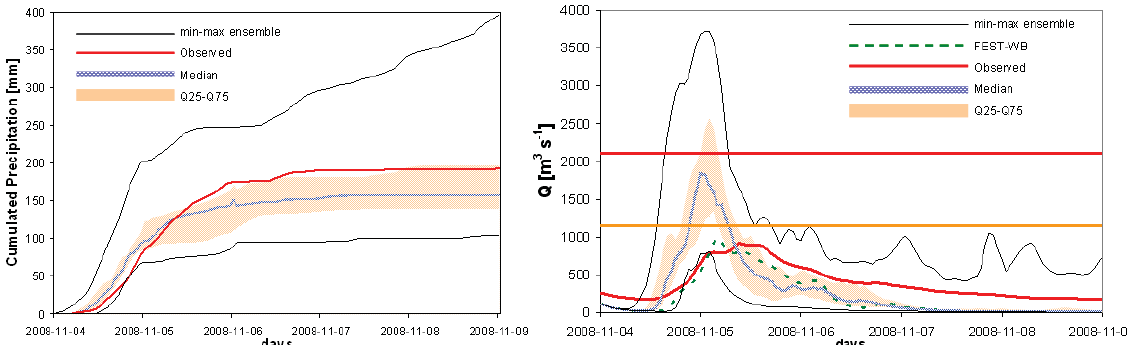
Fig. 4. QPF (left) of the COSMO-LEPS model in comparison to the mean cumulative observed precipitation (red line) over the Toce Basin; the purple line shows the COSMO-LEPS median precipitation, the light orange shadows show the COSMO-LEPS 25th and 75th percentile precipitation and the black lines refer to the COSMO-LEPS envelope precipitation. The run started on 4 November 2008. QDF (right) of the FEST-WB model forced with observed data (green dashed line) and COSMO-LEPS meteorological data. In particular, the red line shows the observed discharge at Candoglia, the purple line shows the ensemble median discharge, the light orange shadows show the ensemble 25th and 75th percentile discharge and the black lines refer to the ensemble envelope discharge. The run started on 4 November 2008. The horizontal orange and red lines are the warning codes 2 and 3, respectively, for the Toce